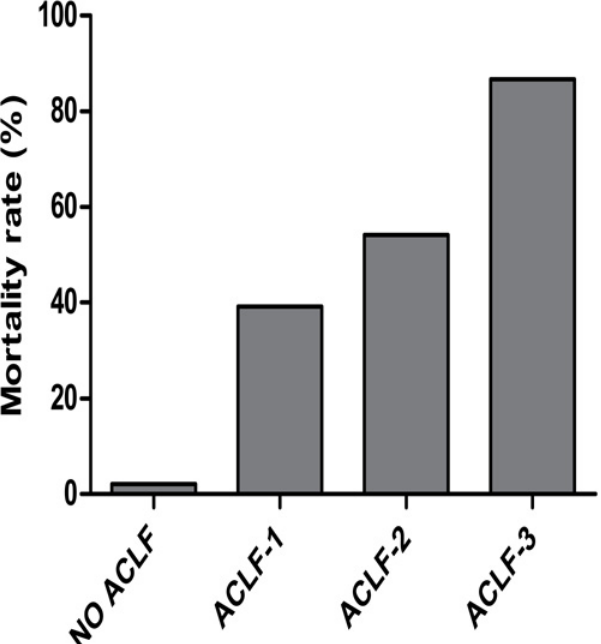
Fig 4. Mortality rate at 90 days according to the grade of ACLF defined by EASL-CLIF Consortium. Among patients identified as EASL-CLIF ACLF either at enrollment or after enrollment, the 90-day mortality rate was 39.1% for grade 1, 54.1% for grade 2, 86.7% for grade 3, respectively. The 90-day mortality rate in patients without EASL-CLIF ACLF both at enrollment and after enrollment was 2.1% . Abbreviations: ACLF, acute-on-chronic liver